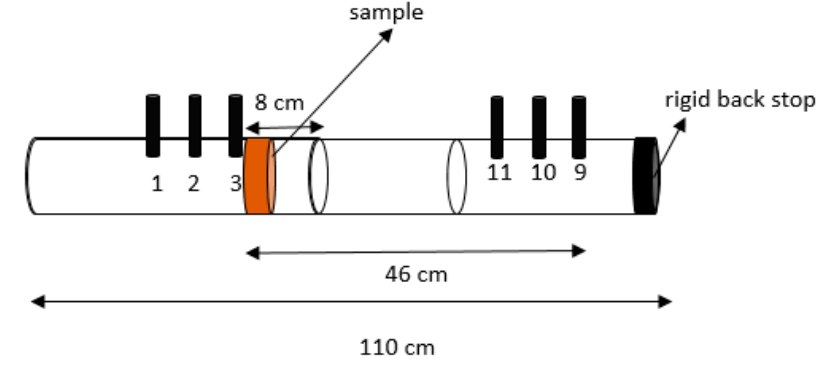
Figure 3. Scheme of the sample configuration for airflow resistivity determinations.